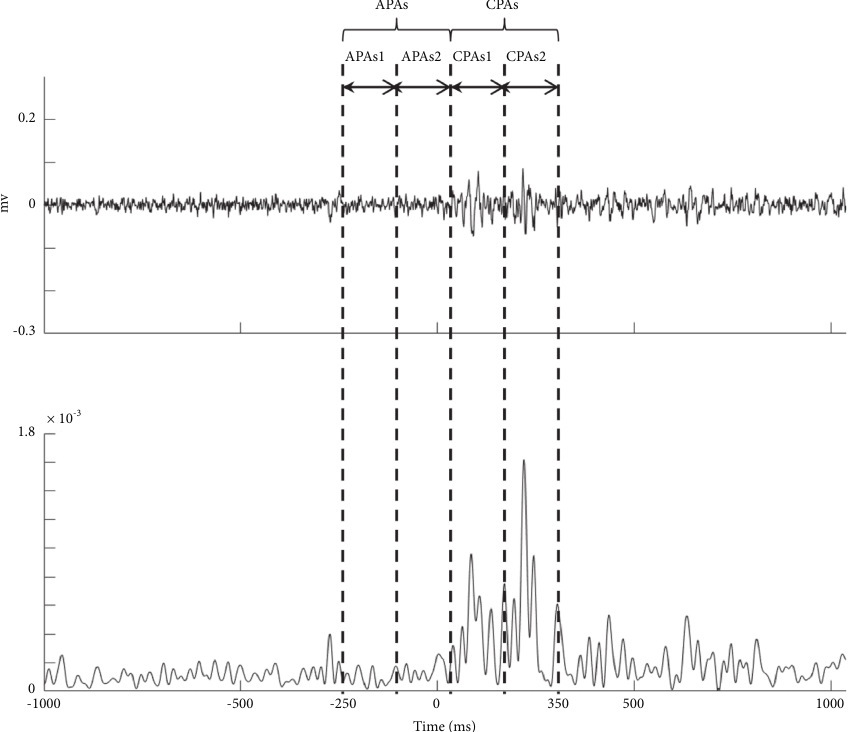
Figure 3: The time window of each subepoch during APAs and CPAs period. The upper panel is the raw sEMG data of rectus abdominis. The lower panel is the sEMG signals after the TKE operation. The zero point at the time axis is the onset time of